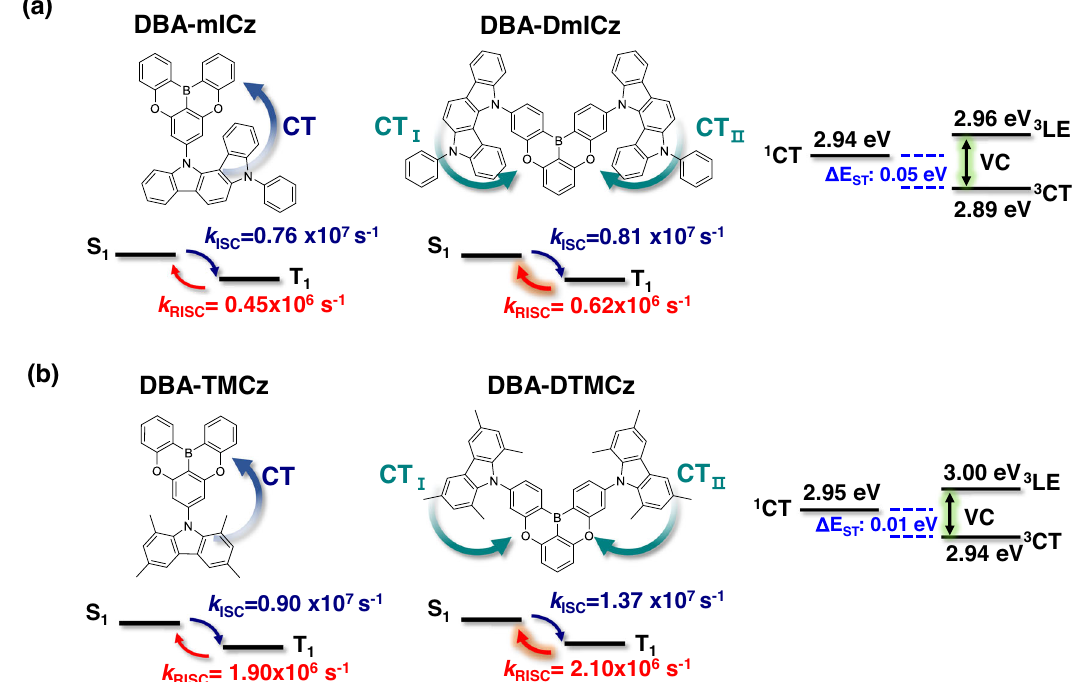
Fig. 4 | Schematic illustration of TADF mechanism. The energy levels and com- parisonofRISCandISCrateconstantsbetweenbipolarD-AandquadrupolarD-A-D types a DBA-mICz and DBA-DmICz, b DBA-TMCz and DBA-DTMCz. The